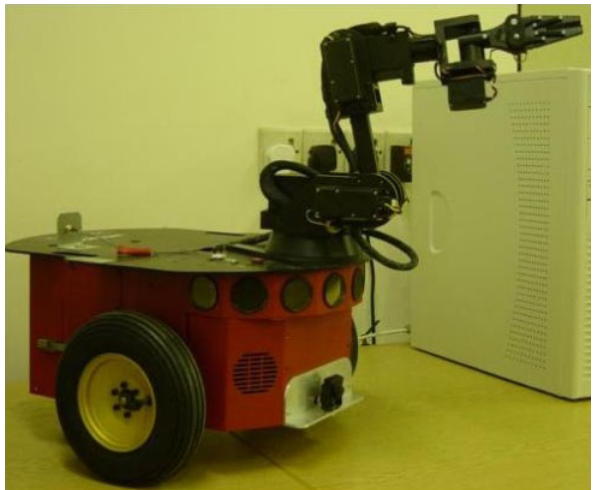
Figure 1 The robot United4 is the robotic platform we used. It is a Pioneer 2DX with a Pioneer Arm and a